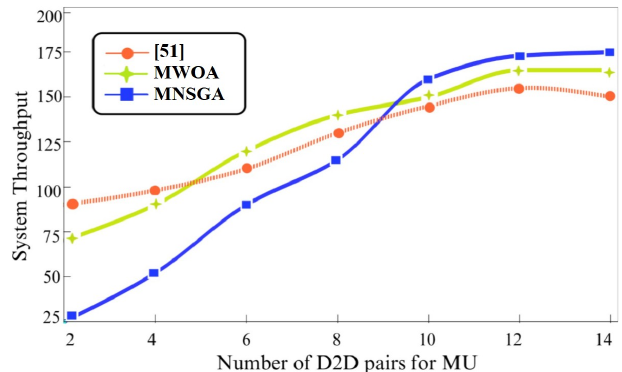
Figure 6. Throughputs for D2D pairs for MU s [51].